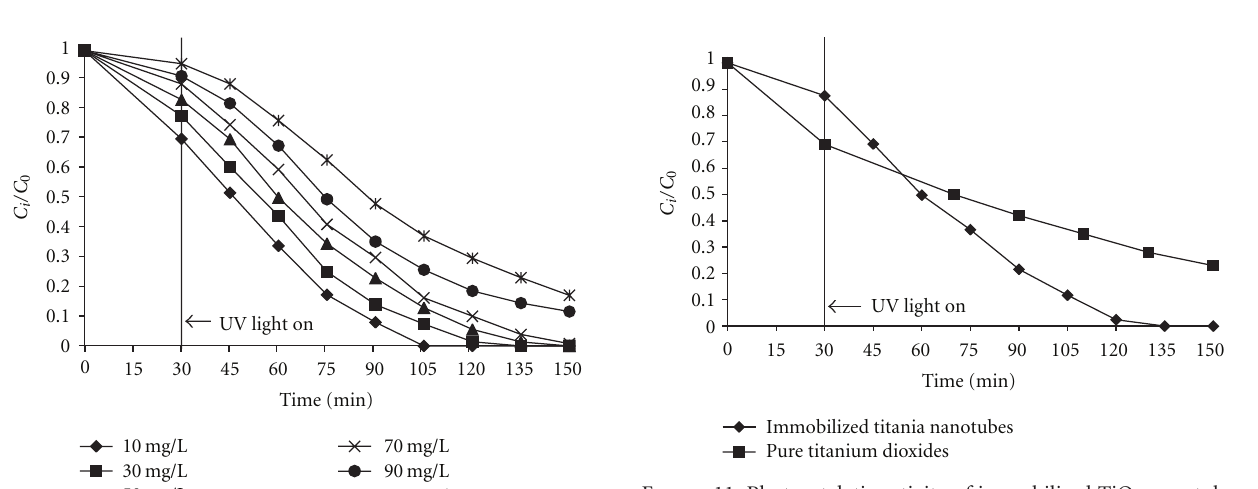
Figure 11: Photocatalytic activity of immobilized TiO 2 nanotubes and pure TiO 2 . Conditions: air flow rate = 0.3L/min, medium pH = 3 and initial phenol concentration =